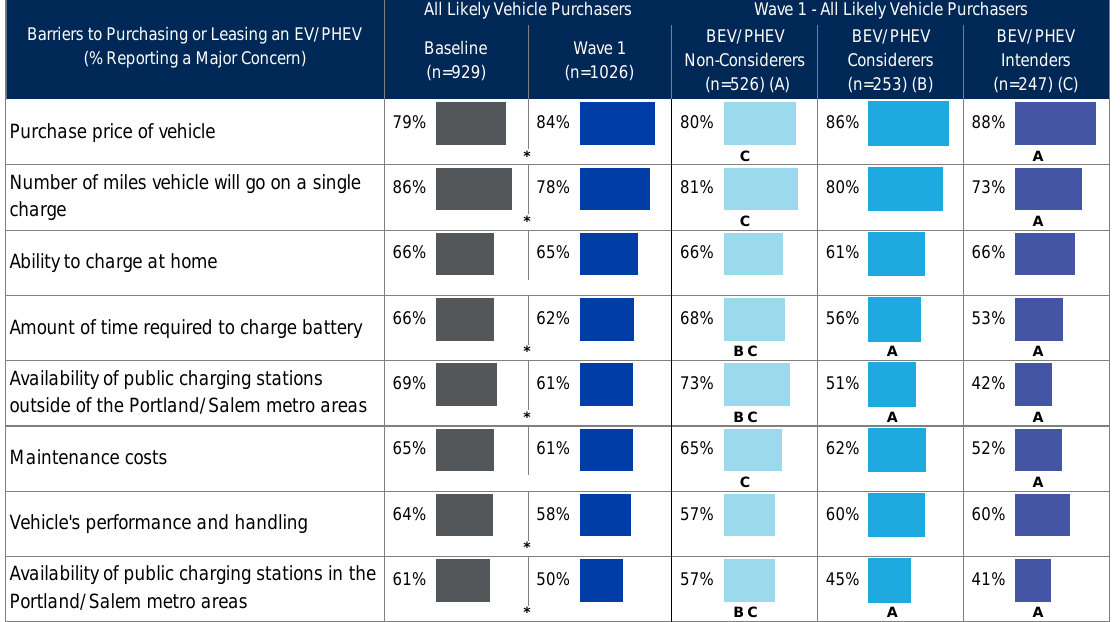
Figure 5. Barriers mentioned to purchasing or leasing an EV, by survey wave and segment (multiple responses allowed). Note: Letters A–C indicate statistically significant differences between likely vehicle purchaser segments (z-test for proportions, p < 0.05). * Indicates a statistically significant difference between Baseline and Wave 1 survey’s all likely vehicle purchasers (z-test for proportions, p < 0.05).